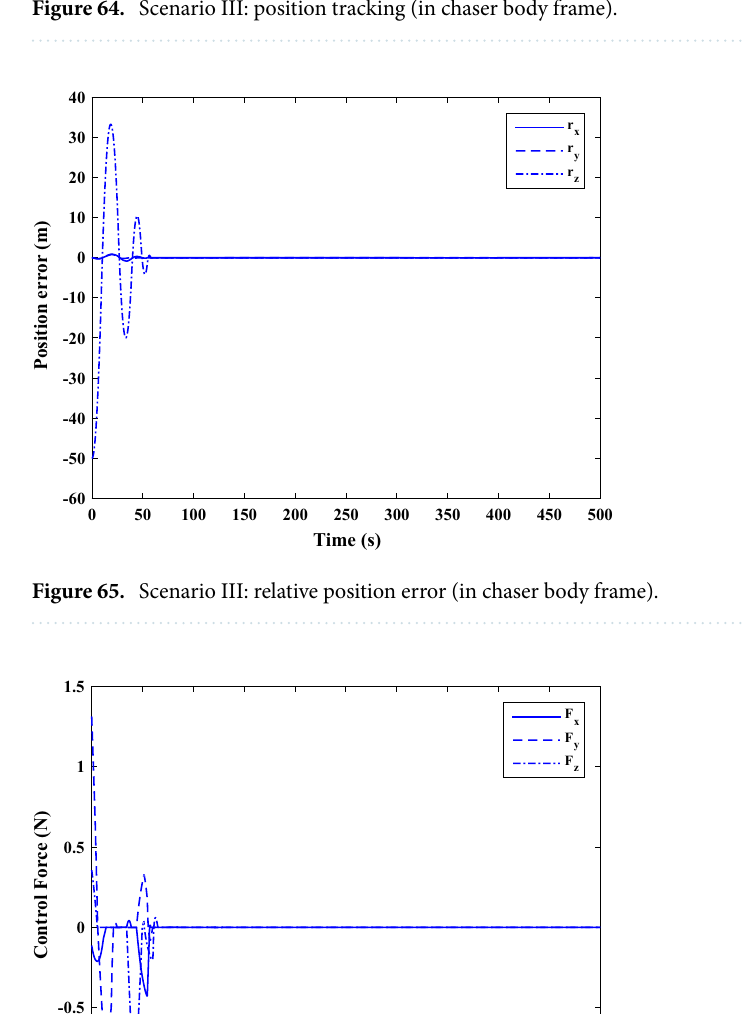
Figure 64. Scenario III: position tracking (in chaser body frame).